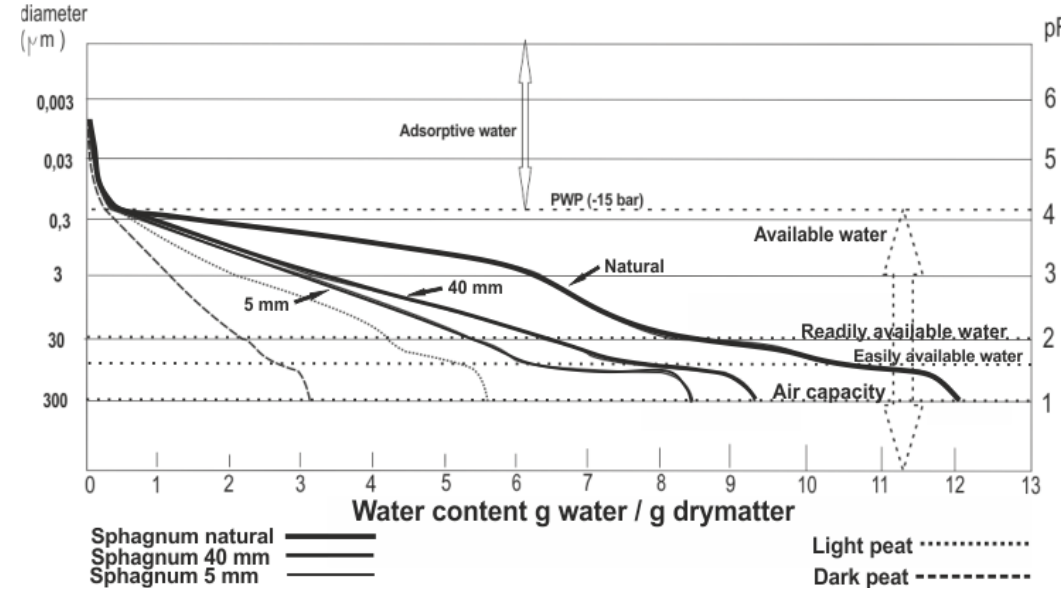
Figure 6. Gravimetric water retention curves for Sphagnum and peat samples. Sphagnum was examined at fibre lengths of 5 and 40 mm and with natural